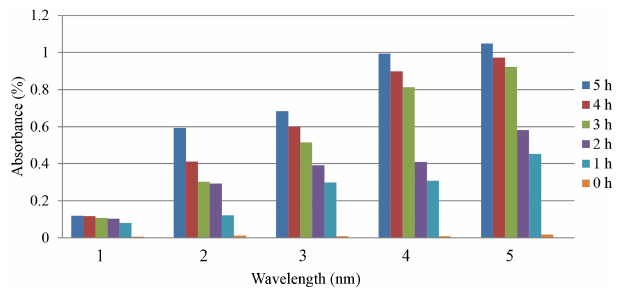
Figure 5. UV–visible spectra of Er 2 O 3 with SL.